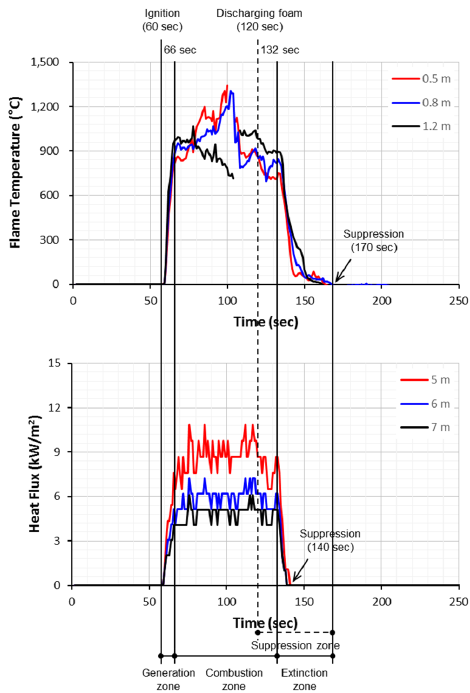
Figure 5. Measured results of specimen I for the flame temperature and heat flux in accordance with the measured distance.